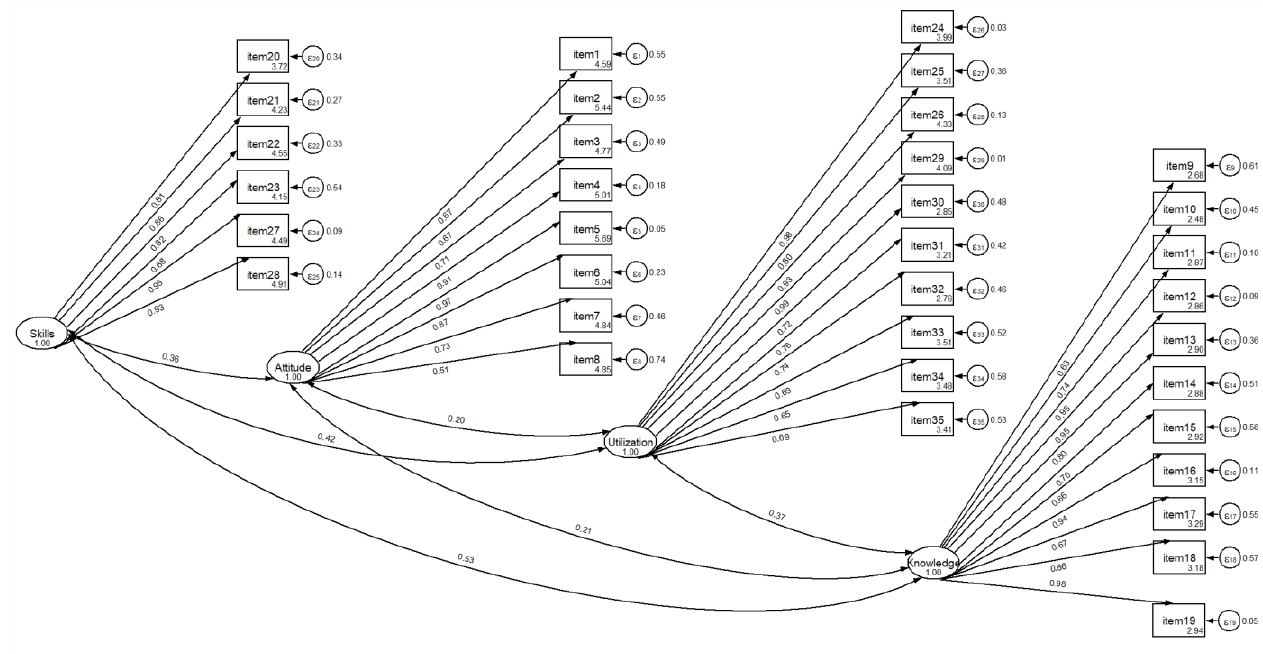
Figure 1. Confirmatory factor analysis of the Greek EBP-COQ Prof .